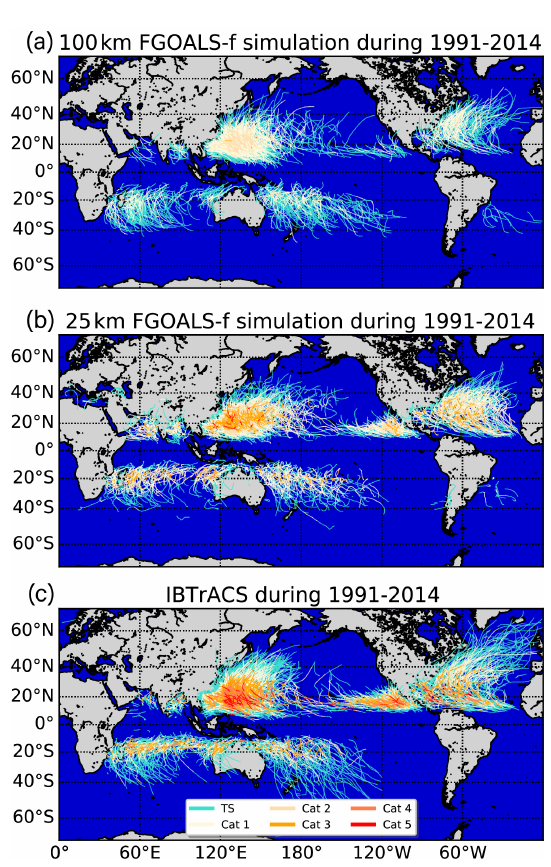
Figure 1. Global tropical cyclone tracks (lines) and intensities (col- ors) during the time period 1991–2014 between (a) FGOALS-f3-L, (b) FGOALS-f3-H and (c) IBTrACS. The tropical cyclones simu- lated by FGOALS-f3-L/H are picked out using an objective feature- tracking approach, and only those tropical cyclones with a lifetime > 3d are shown. The definition of intensity threshold is consistent with the Saffir–Simpson scale: TS, tropical storm; Cat 1–5, category 1–5.